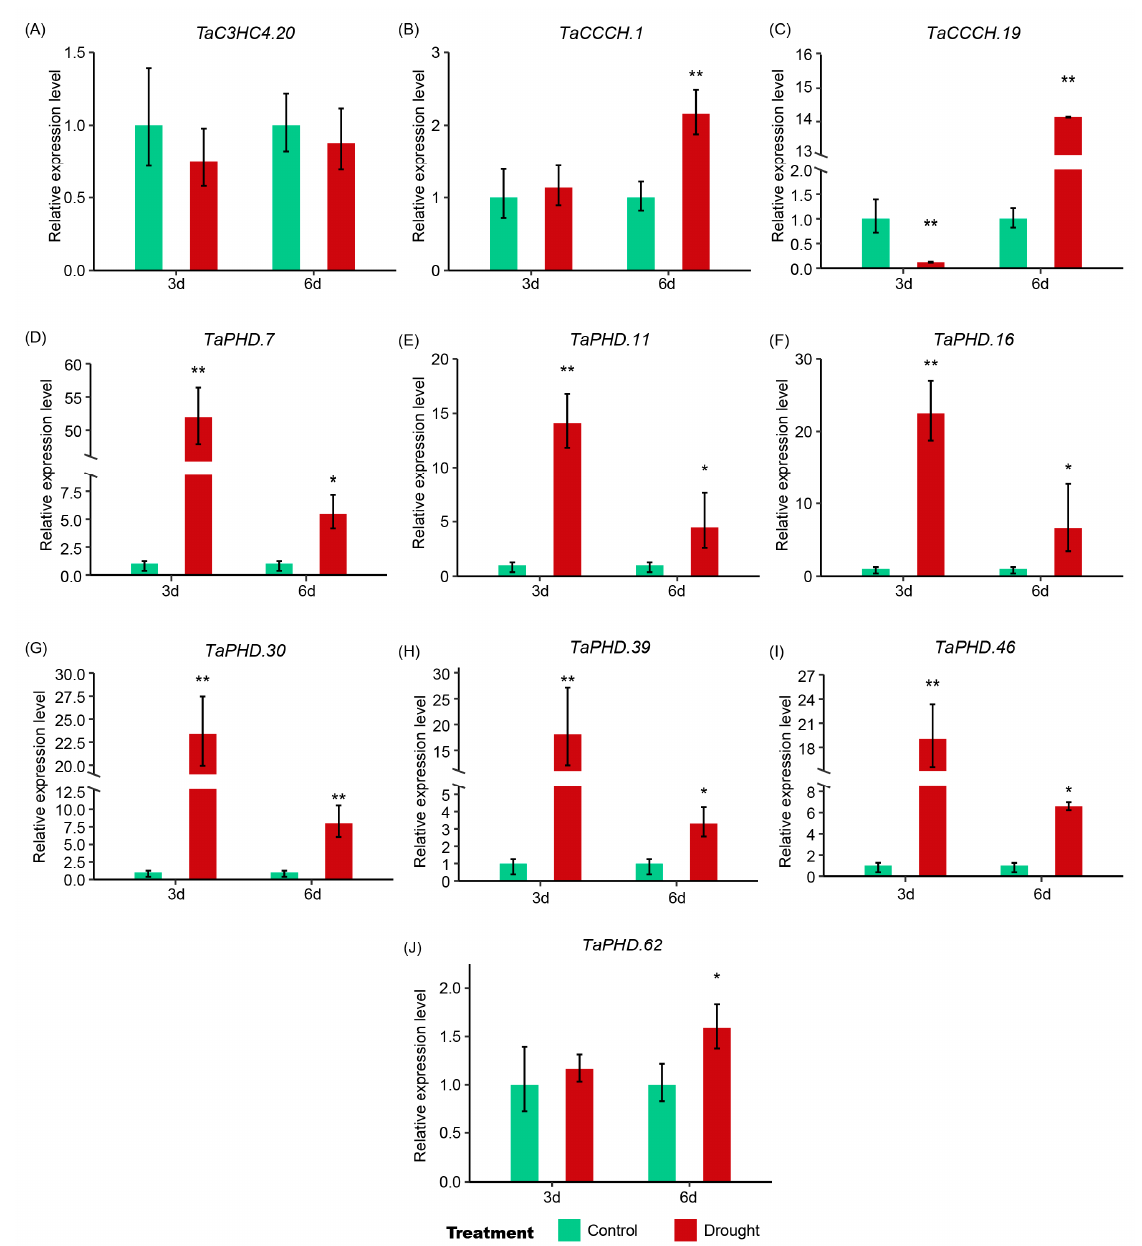
(Figure 8). Except for TaC3HC4.20 , the relative expression levels of nine genes were in- creased in DS-3d and DS-6d treatment. Among them, six genes from the PHD-VI subgroup (Figure 8D–G,I) showed similar differential expression patterns. Their relative expression levels increased by at least 10 times under DS-3d treatment and about 5 times after DS-6d treatment. The expression levels of TaCCCH.1 and TaPHD.62 were the same as those of reference genes under DS-3 d but increased at DS-6 d. Based on the results of qRT-PCR, the Figure 7. TaZFP gene expression levels heatmap at different treatment times and tissues under expression profiles of the 10 TaZFP s were generally consistent with previously published drought stress. TPM values were scaled by the logarithm of the base 10 to form the heatmap. data.